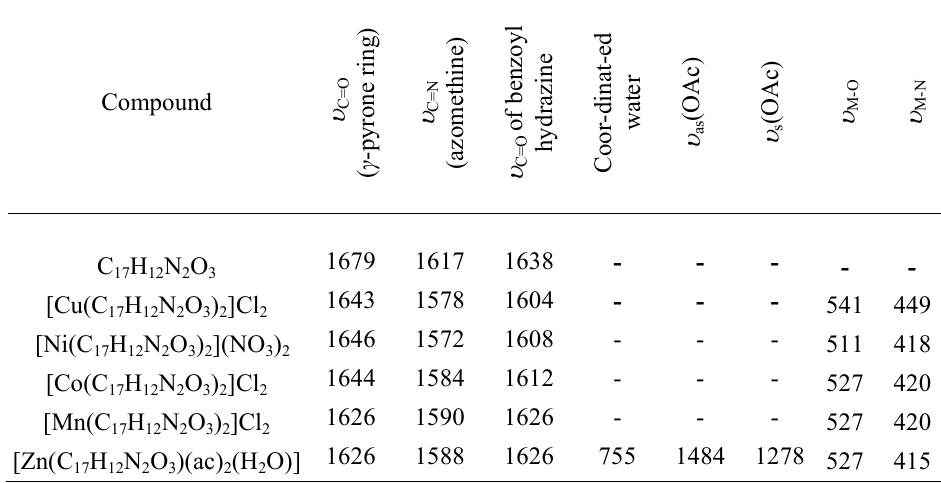
Table 2. Characteristic IR stretching bands of Schiff base ligand and its metal complexes in cm -1